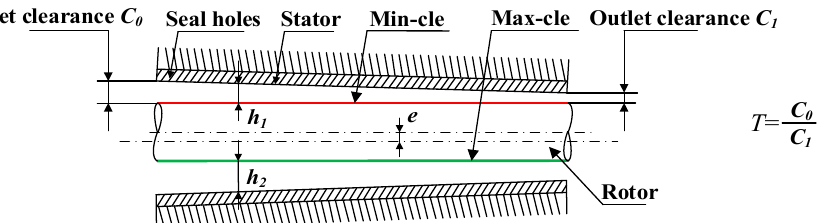
Figure 2. Schematic diagram of pressure extraction for minimum and maximum sealing